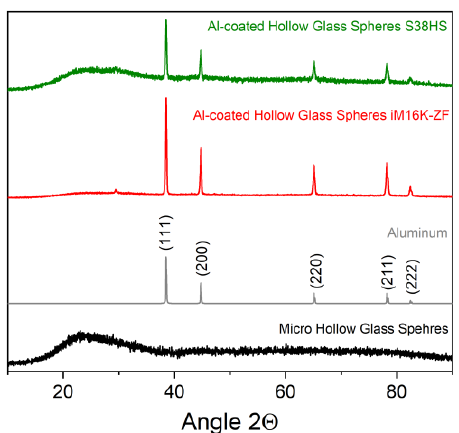
Figure 9. Qualitative comparison of X-Ray Diffraction of uncoated and LPD-coated MHGS. Besides the characteristic halo of amorphous materials, all characteristic peaks of metallic aluminum are detected on the coated